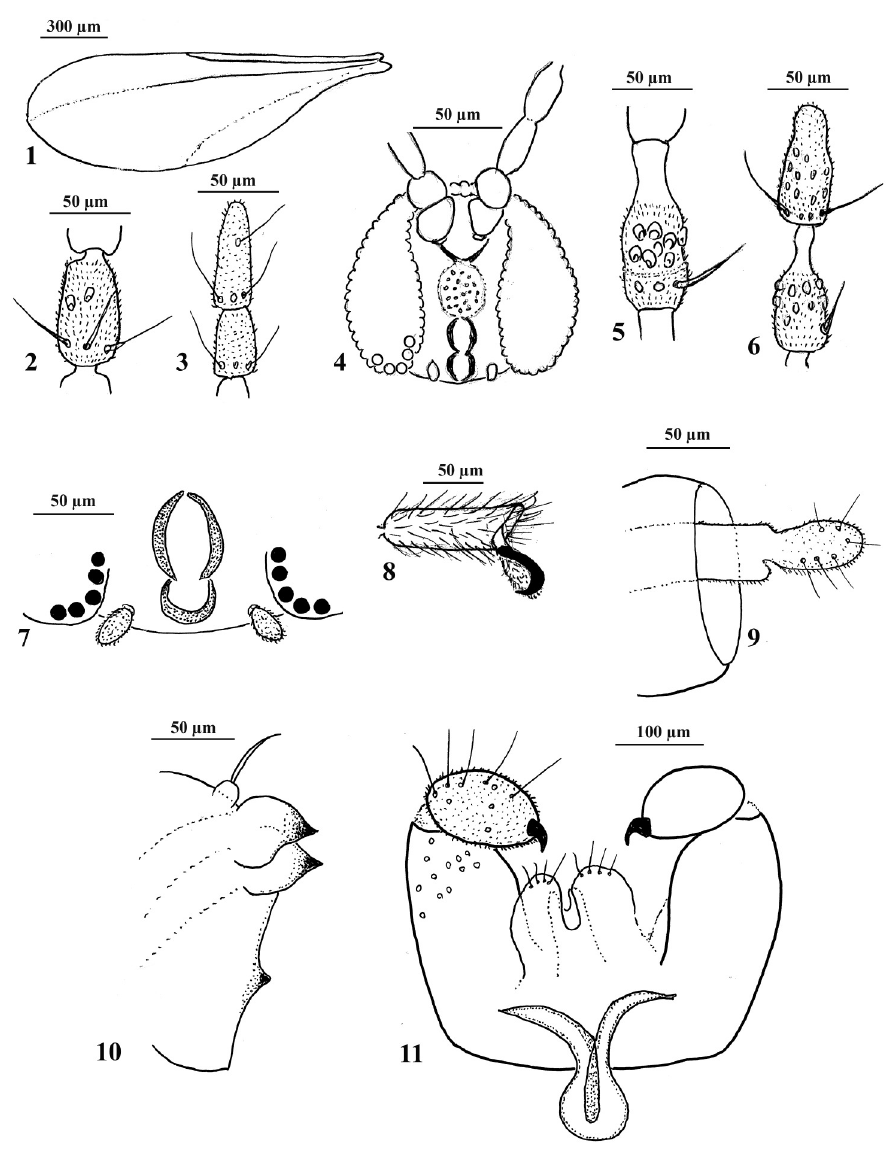
Figures 1–11. Rhopalomyia protrahenda comb. n. 1 Females wing 2 female, fifth flagellomere 3 female, two apical flagellomeres 4 female, head 5 male, fifth flagellomere 6 male, two apical flagellomeres, 7 fema- le, mouthparts, 8 fifth tarsomere with simple claw and empodium 9 terminal part of ovipositor 10 pupal head, lateral view 11 male terminalia.